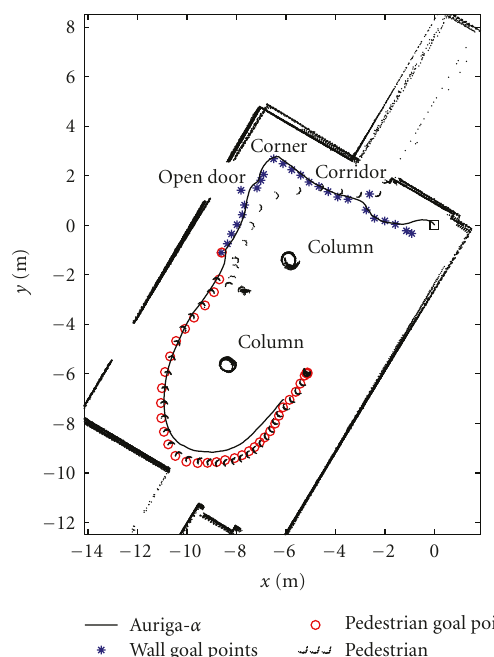
Figure 11: Tracked path along an indoor hall while following a wall and a